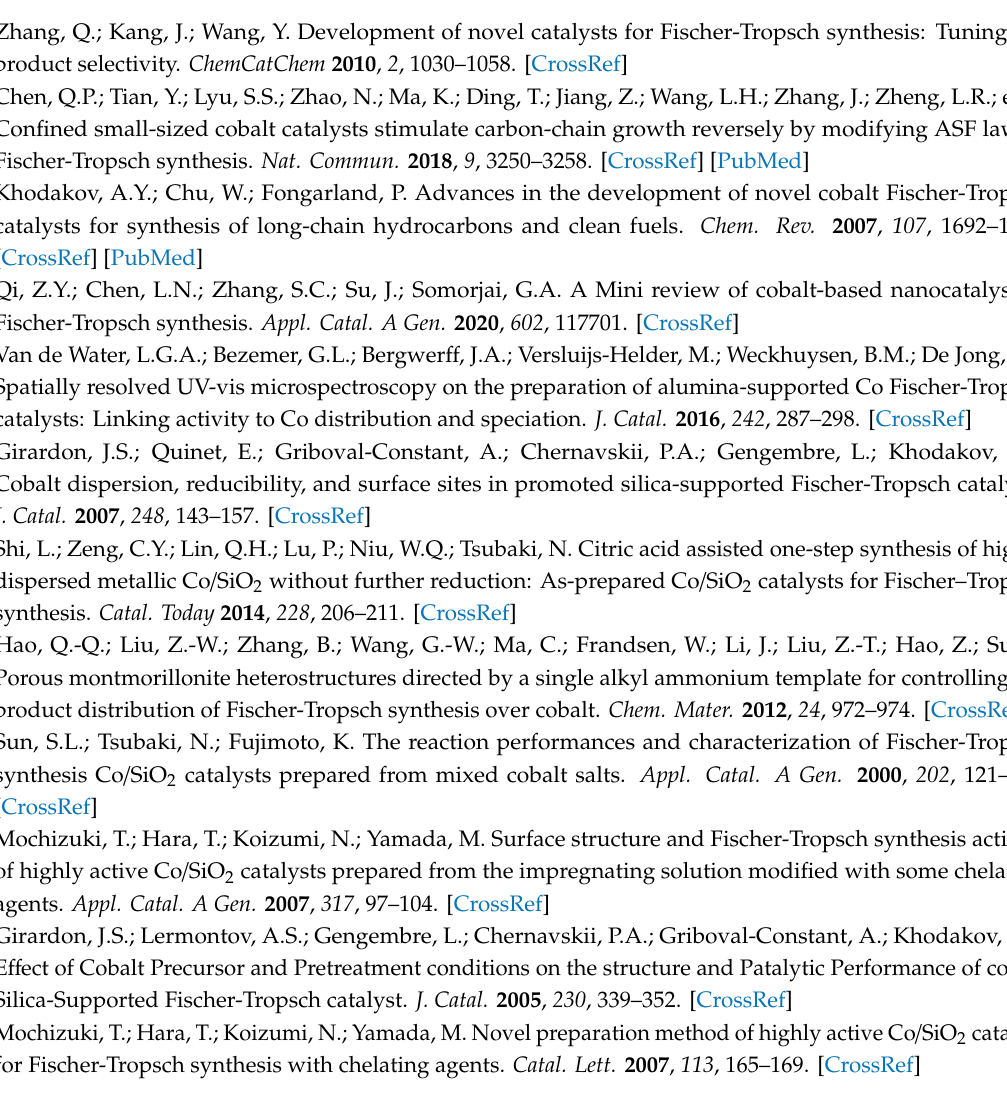
Figure S1: N 2 adsorption-desorption isotherms and BJH pore size distribution of the